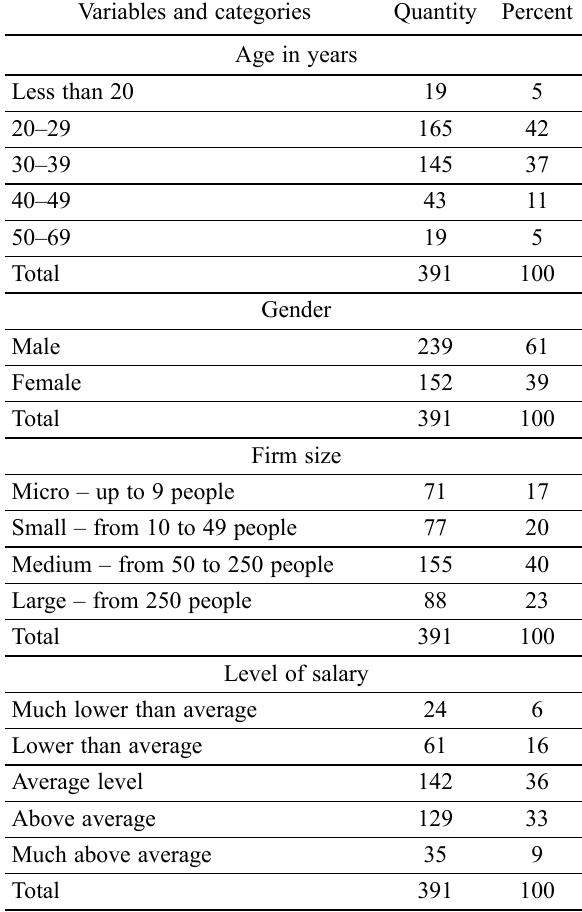
Table 5 . Sample characteristics (N =